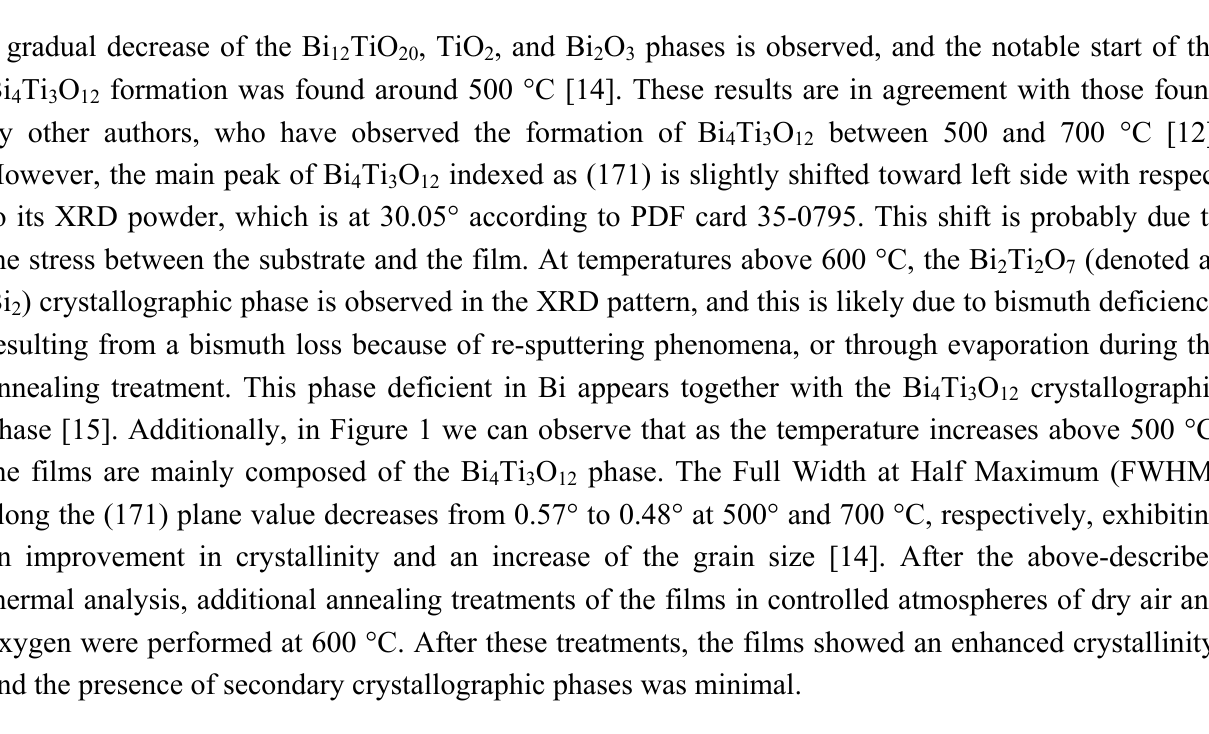
Figure 2. XRD patterns of Bismuth titanium oxide film with annealing treatment during 5 min in oxygen atmosphere. Bi Bi Ti O (Bi 2 2 7 2